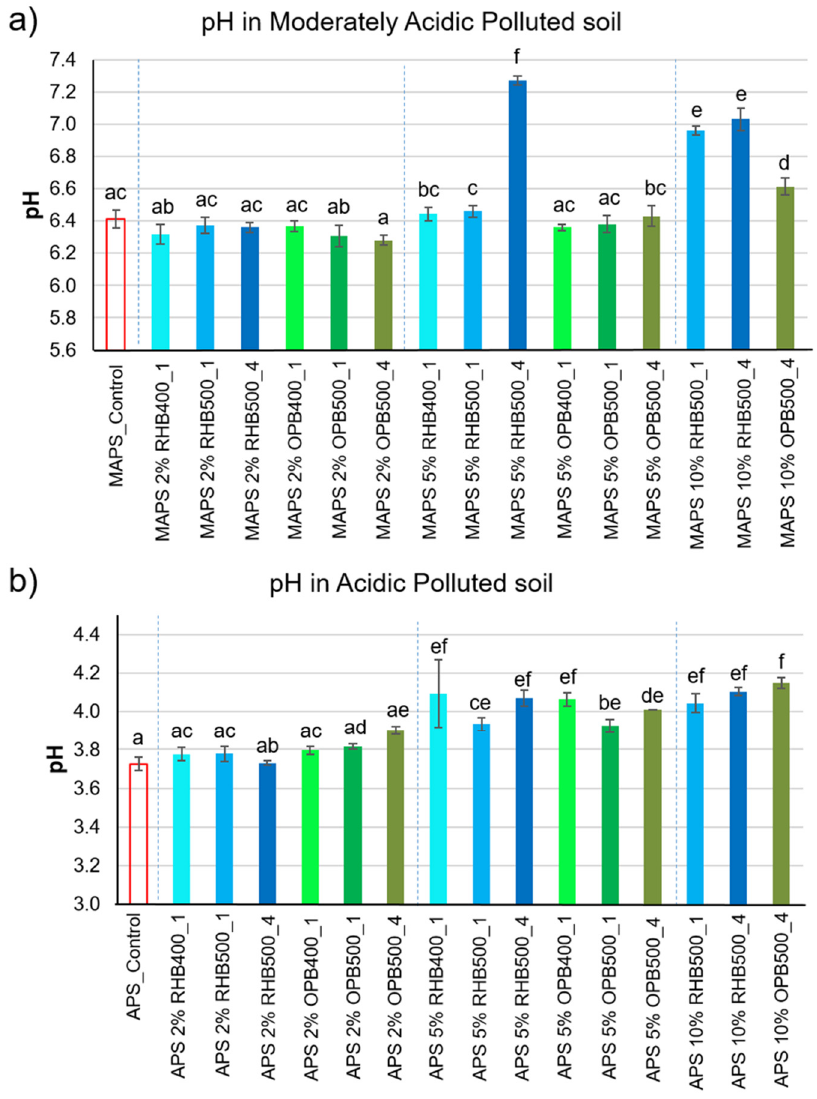
Figure 1. Soil pH in control and amended pots after 65 days of incubation for ( a ) moderately acidic polluted soils (MAPS) and ( b ) acidic polluted soils (APS). Different letters indicate differences among treatments in each soil ( p < 0.05).